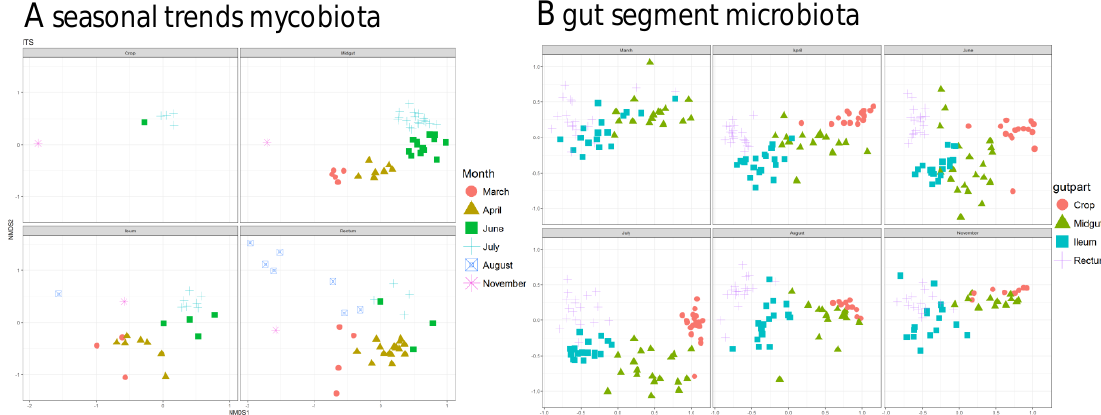
Figure 3. Nonmetric multidimensional scaling (NMDS) plots showing clustering of samples from different gut-parts based on ( A ) mycobiota and microbiota ( B ) composition. The stress values in all cases were < 0.2, suggesting a proper dimension reduction. The reason to present panels connected to gut segment for the mycobiota and season for the microbiota is to highlight the main differences visually.